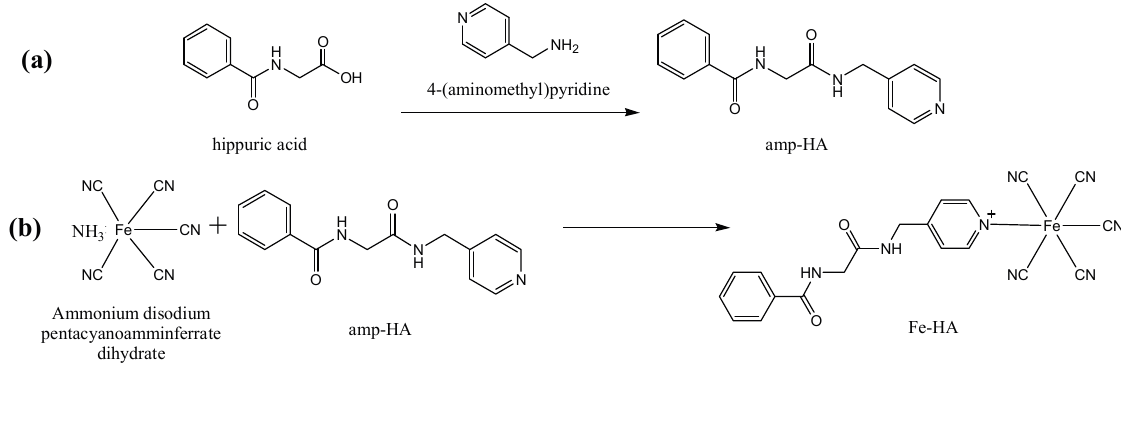
Figure 2. Preparation of Fe-conjugated HA antigen [Fe(CN) 5 (amp-HA)] 3 − /2 − (Fe-HA).